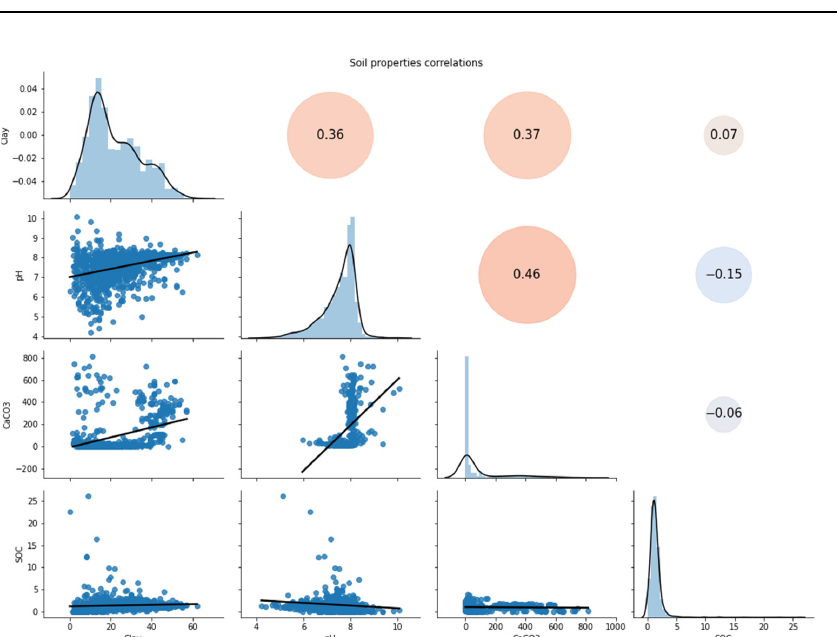
Figure 6. Probability density estimations and pairwise scatterplots and correlations of the soil prop- erties as analyzed in the